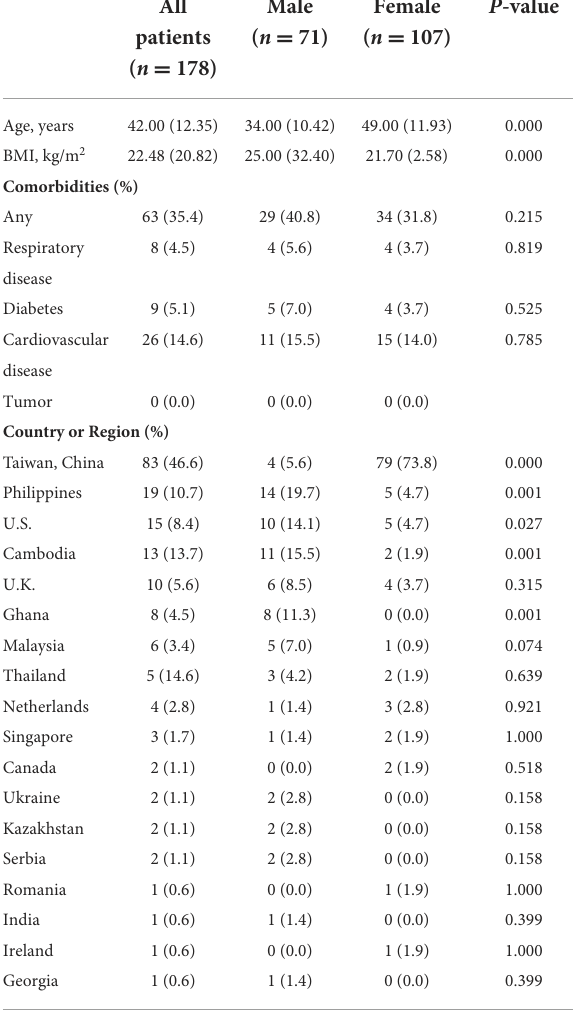
TABLE 2 Clinical symptoms of symptomatic subjects from overseas by gender. All patients